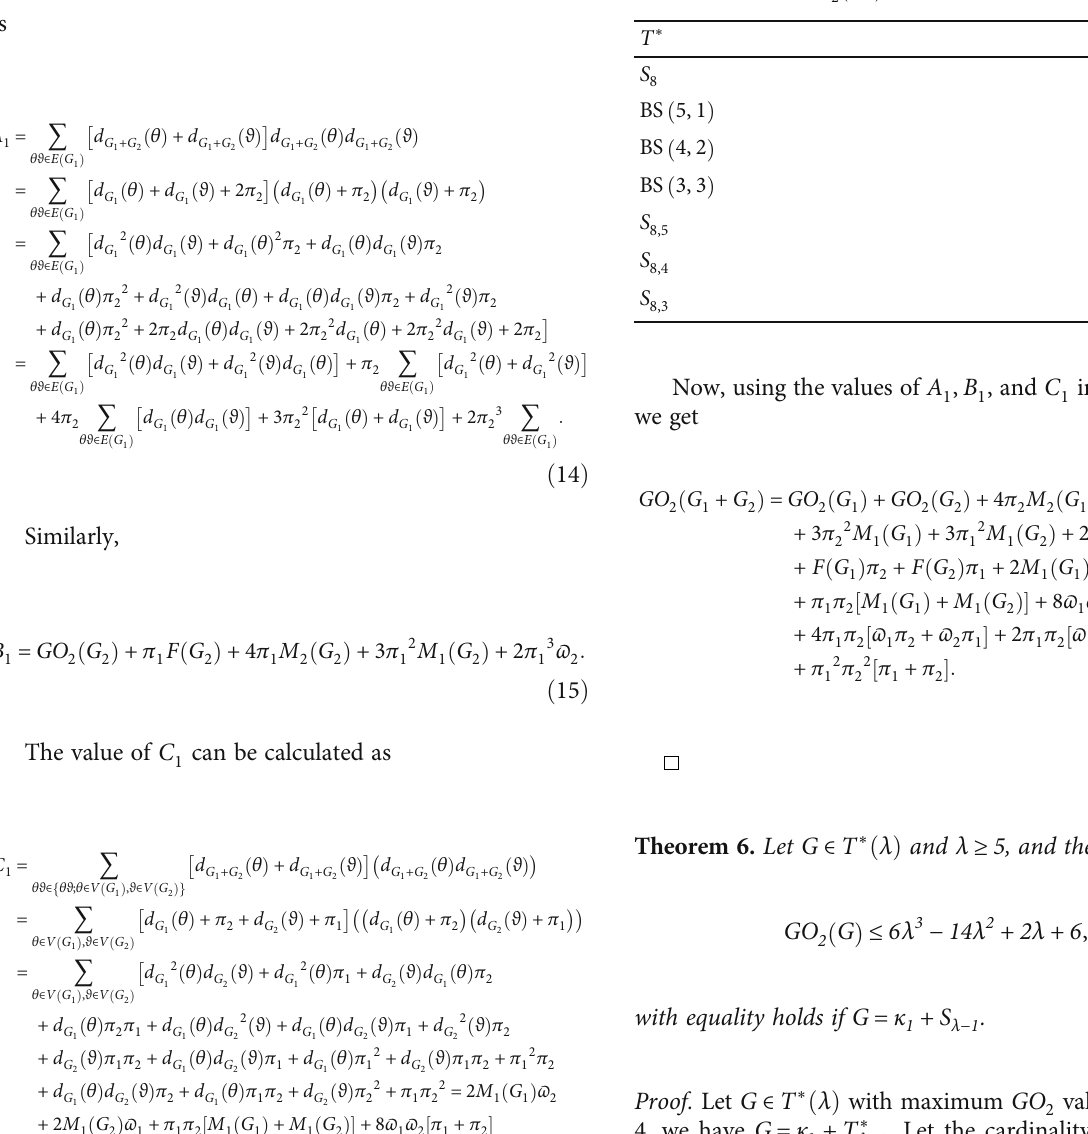
T ∗ Þ of certain trees T ∗ of order 8 Table 1: GO 2 ð